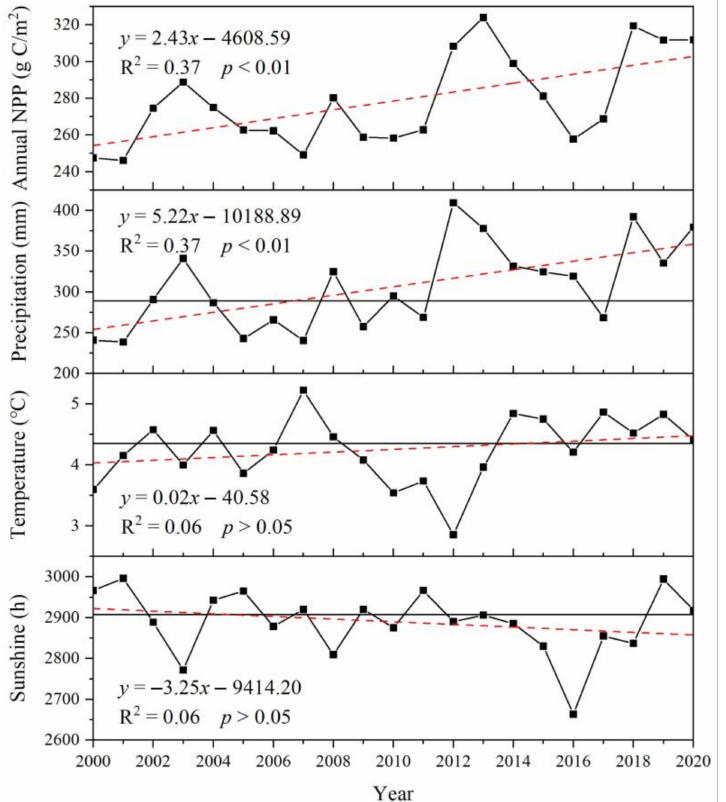
Figure 8. Interannual change trends of grassland NPP and meteorological factors obtained by the OLS method for the Inner Mongolia